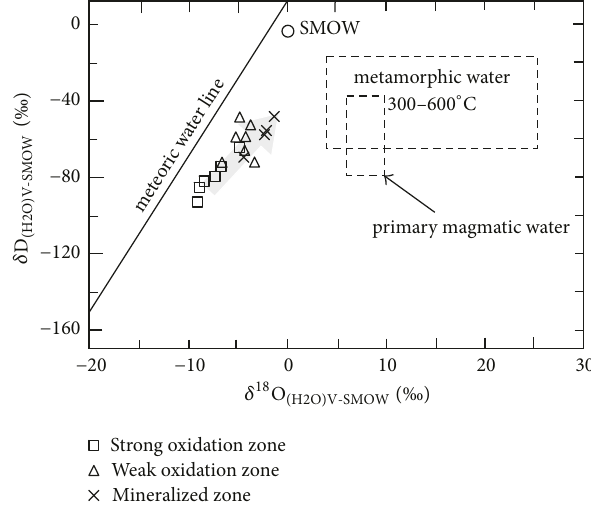
Figure 8: Plot of 𝛿 D versus 𝛿 18 O for kaolinite-forming fluid in the Mengqiguer uranium deposit. Fields for SMOW, metamorphic water, primary magmatic water, and meteoric water lines are referred to Taylor Jr.